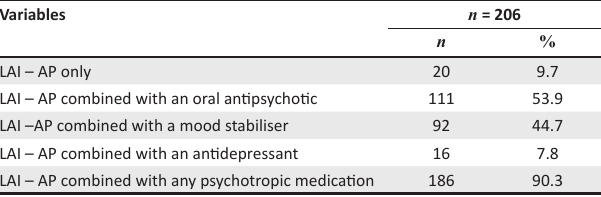
TABLE 3: Concurrent prescription of long-acting injectable antipsychotics and psychotropic medication. Variables